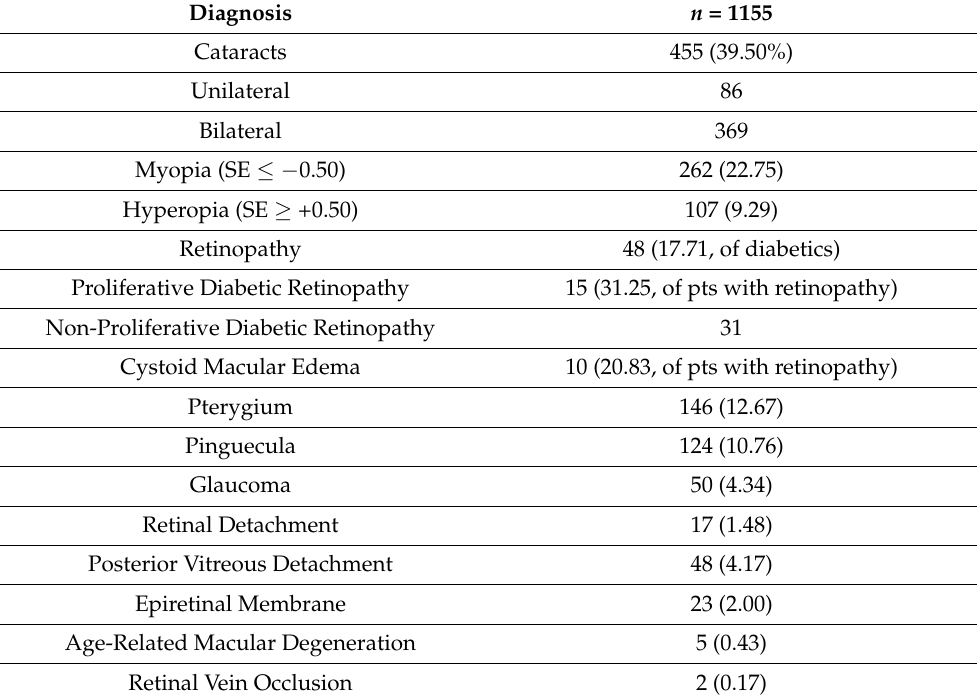
Table 3. Diagnoses,